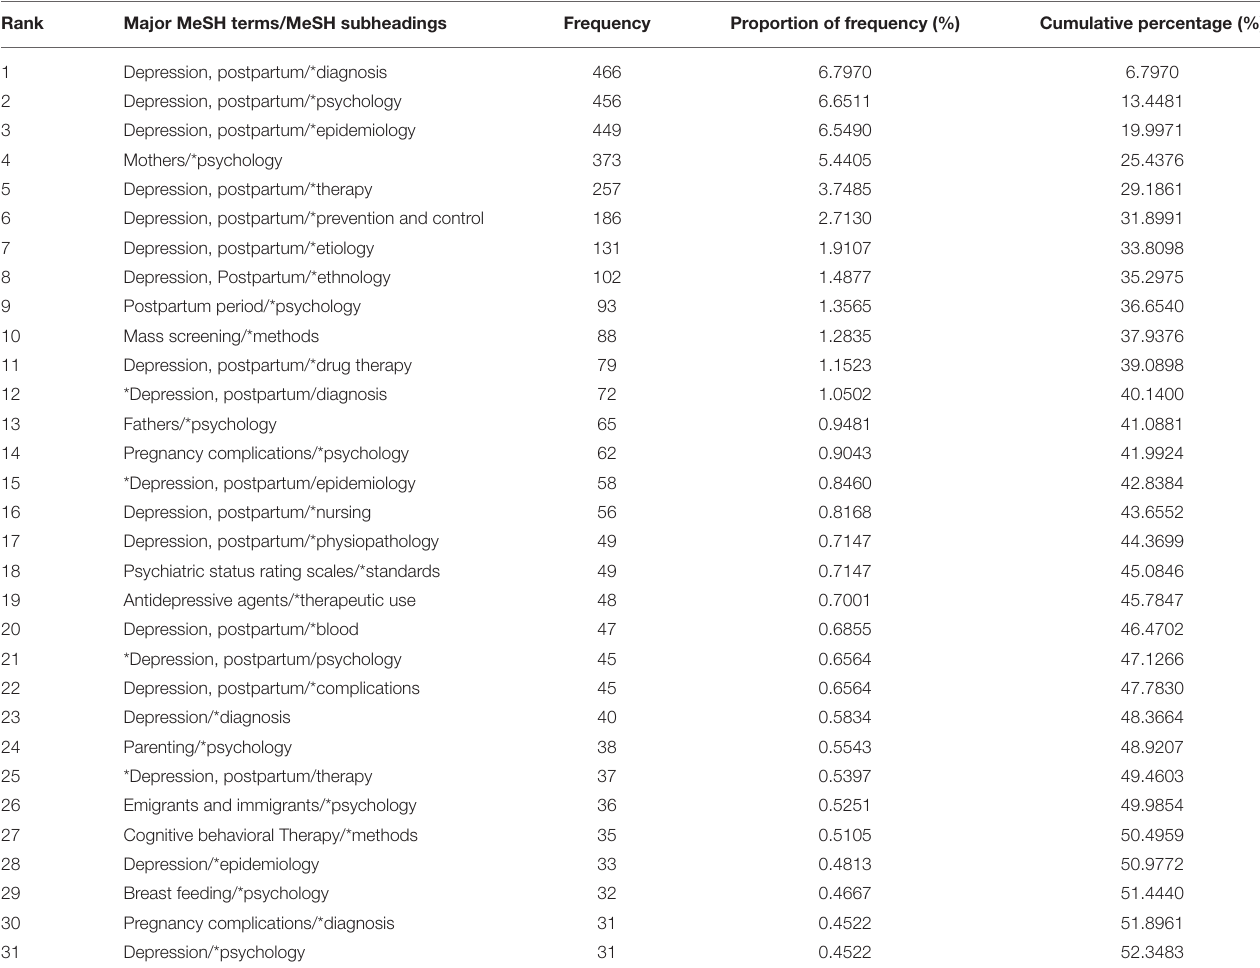
TABLE 3 | High-frequency MeSH terms from the included papers on postpartum